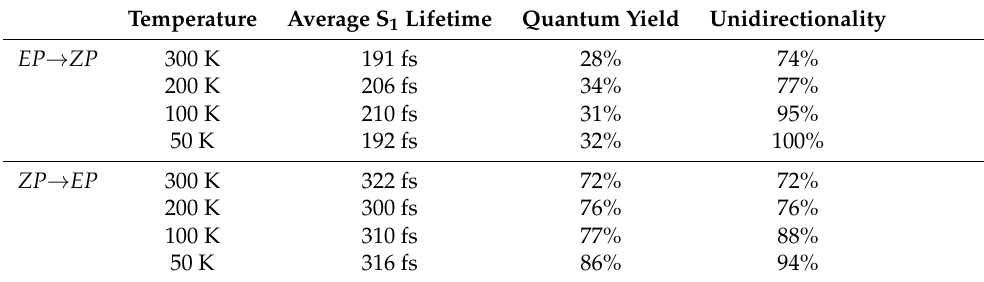
Table 2. The average S 1 lifetime, quantum yield, and unidirectionality for EP → ZP and ZP →